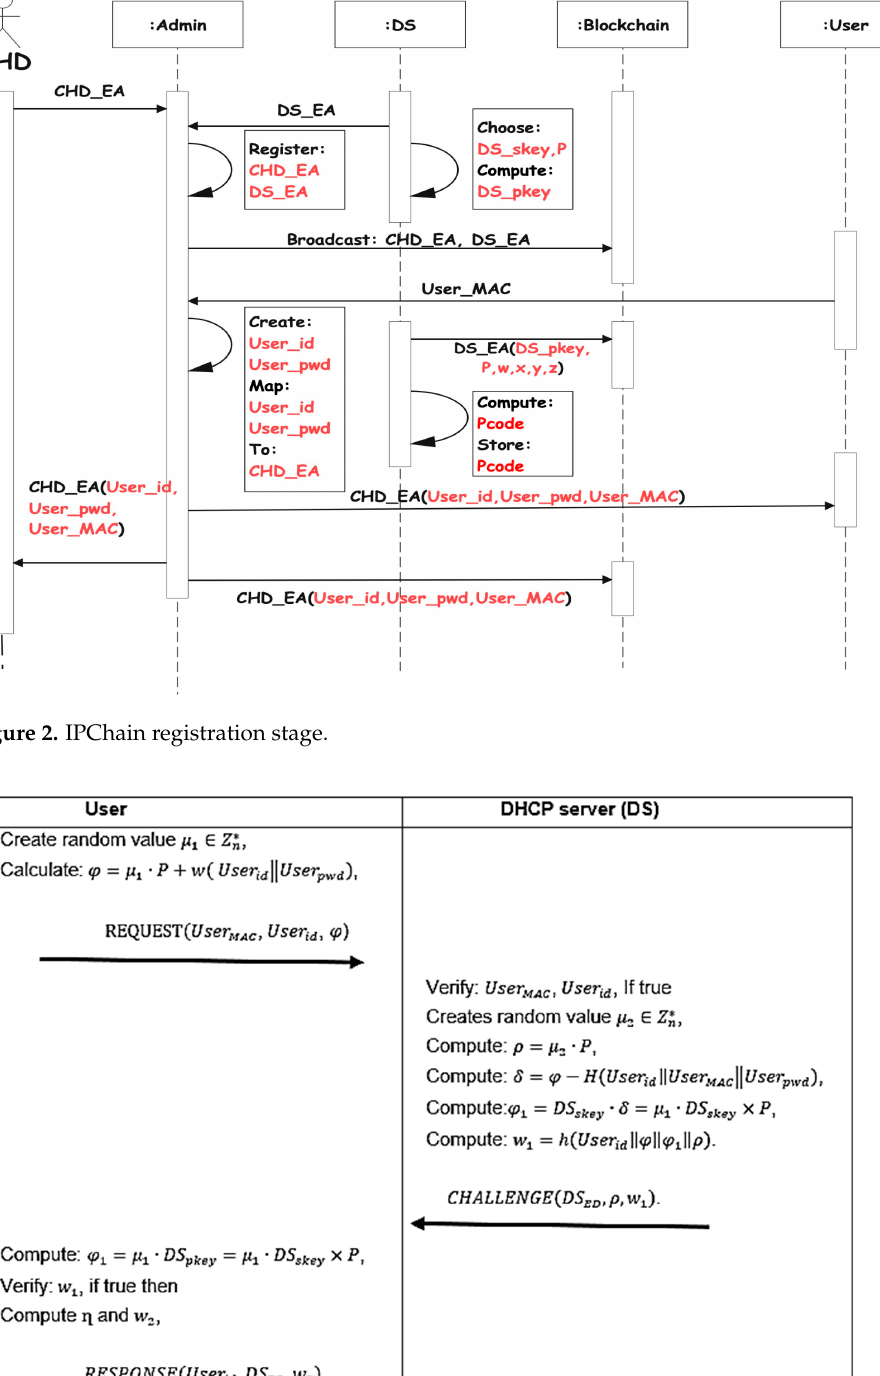
Figure 3. IPChain validation stage.